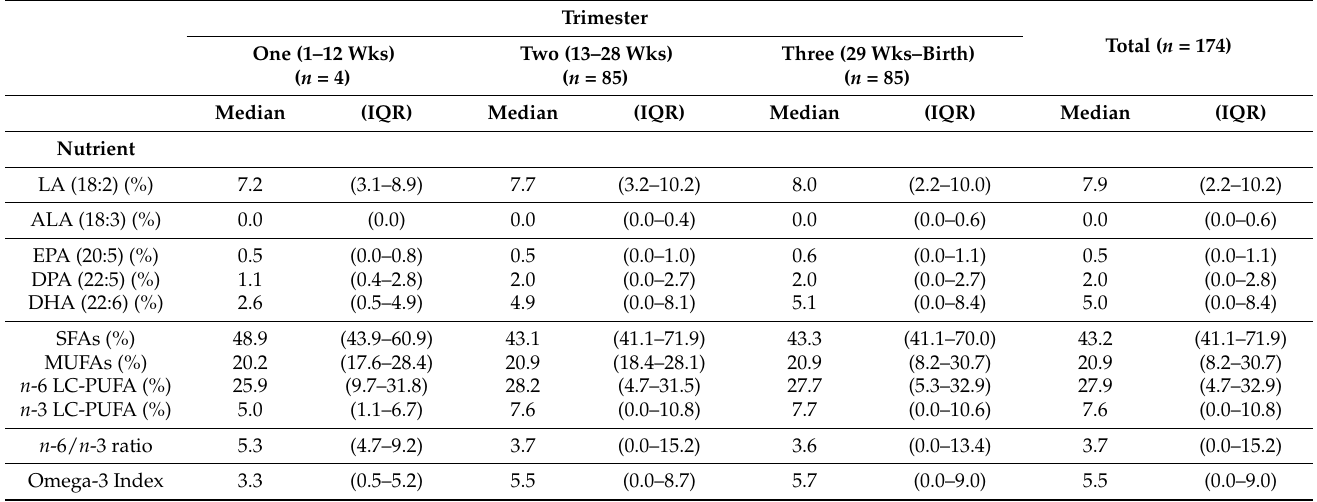
Table 5. Fraction of long-chain polyunsaturated fatty acids and full fatty acid profile of red blood cell membranes at each trimester of pregnancy in women from the Gomeroi Gaaynggal cohort. Trimester